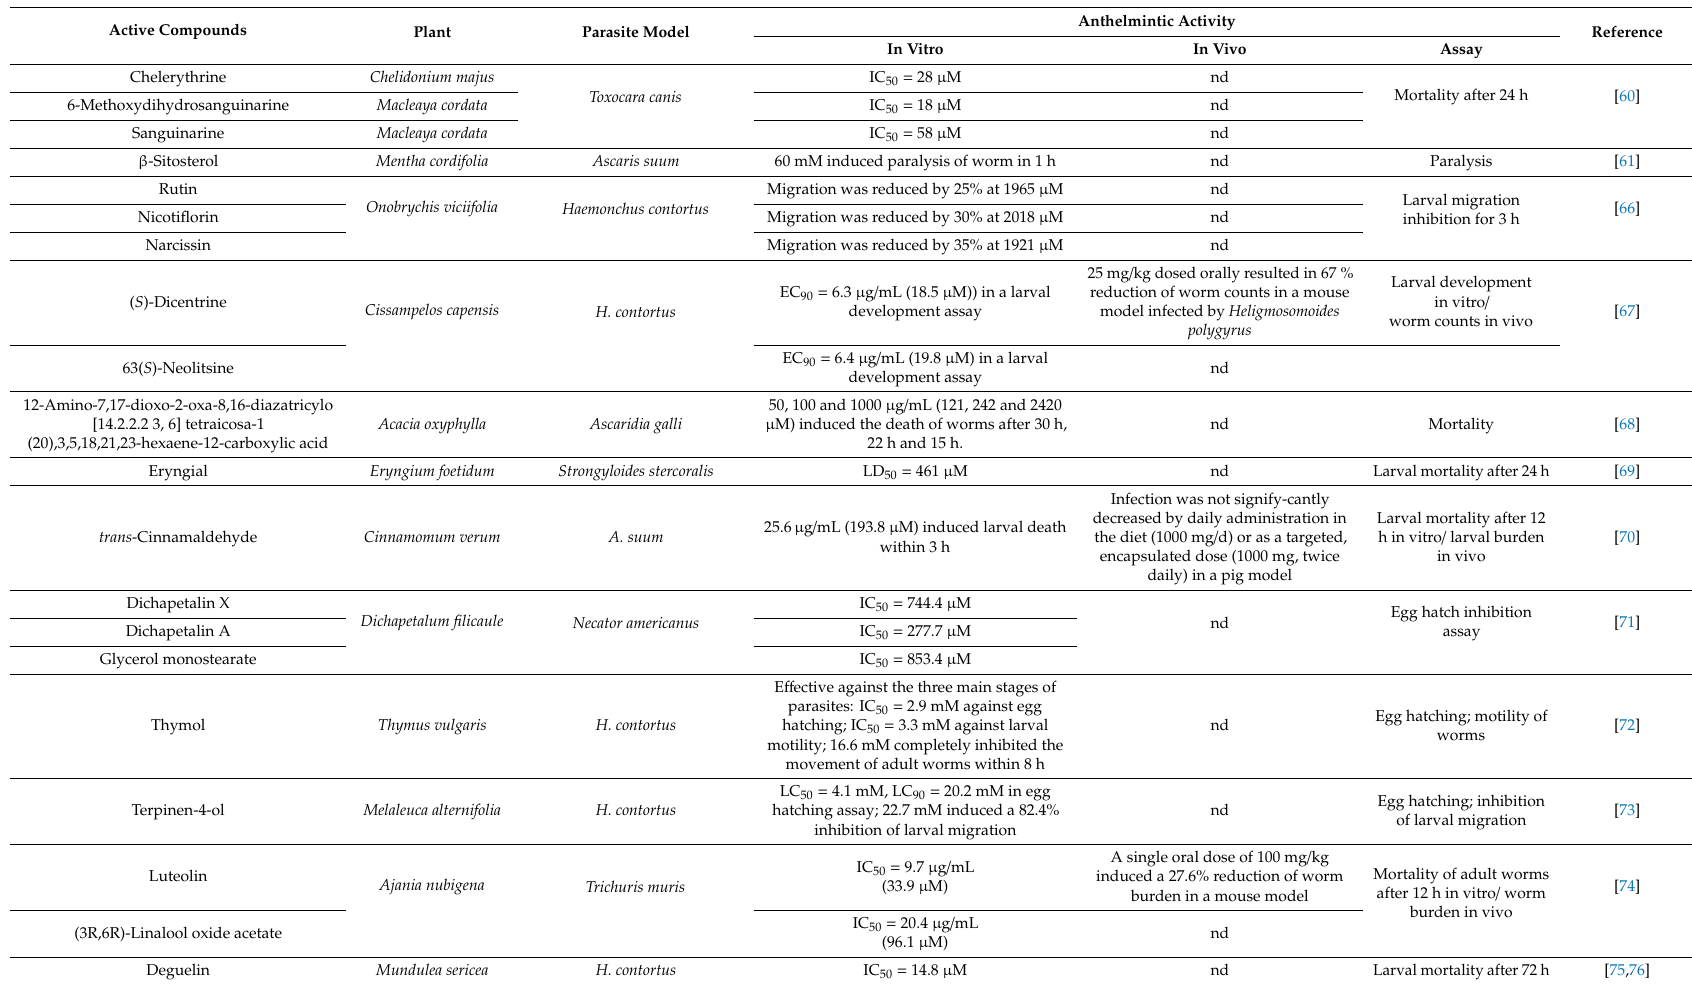
Table 2. List of natural products derived from medicinal plants against intestinal parasitic nematodes.